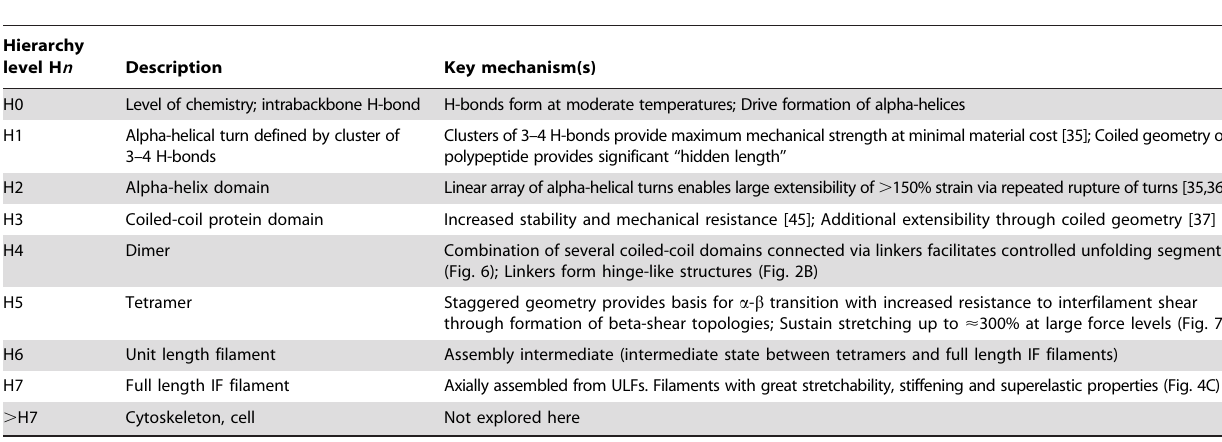
Table 1. Role and mechanism of individual levels of structural hierarchies in IFs (see Fig. 1 for schematic of structure and labeling of hierarchical